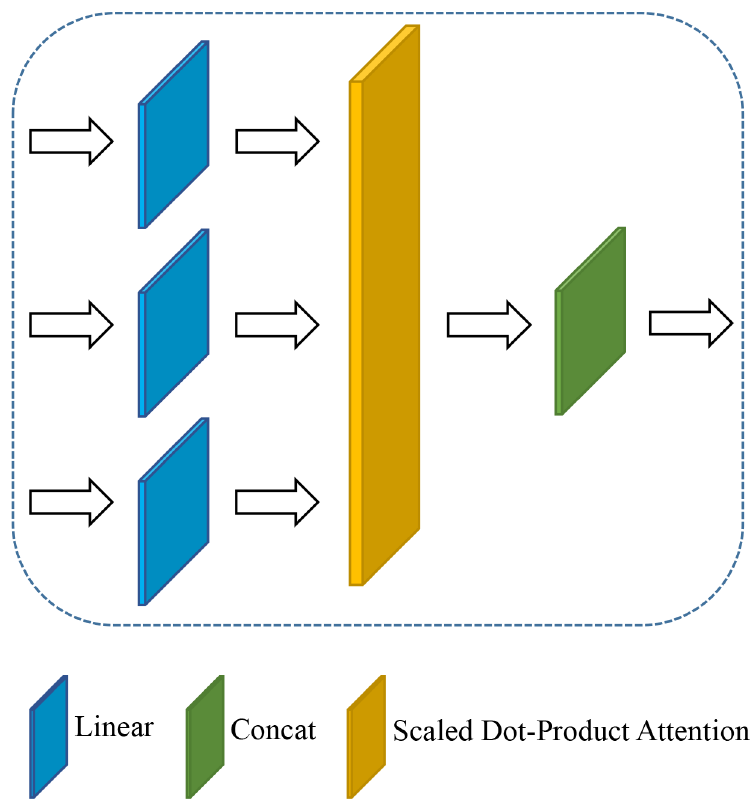
Figure 9. Structure of multi-head